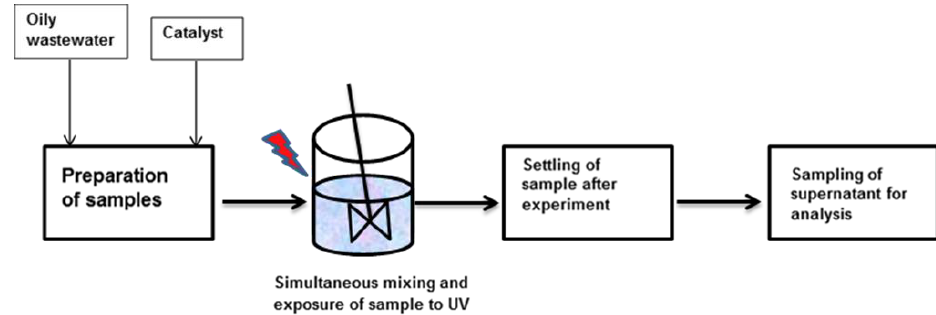
Figure 2. Process flow diagram for this study.